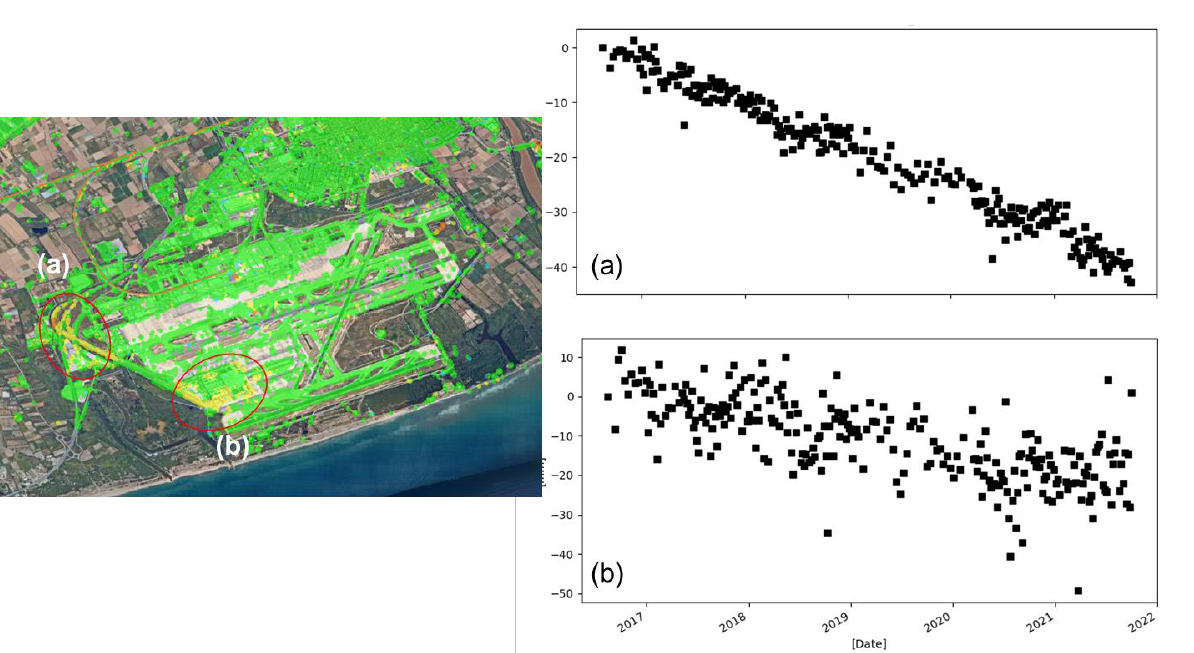
Figure 9. Subsidence in Aeroport de Barcelona-El